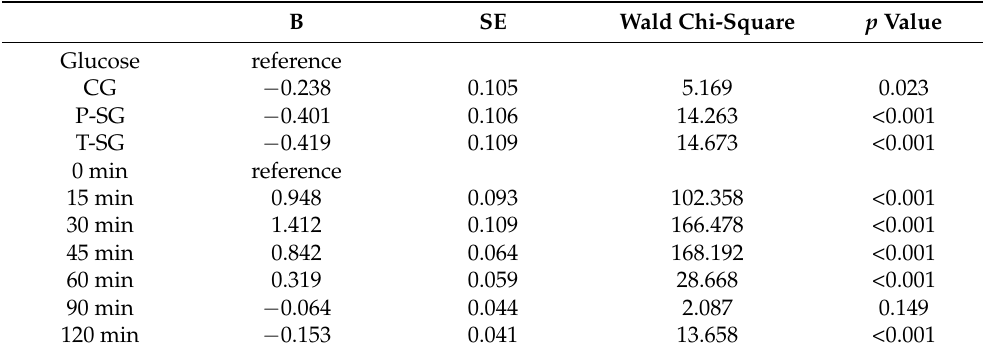
Table 1. GEE analysis results of blood glucose concentration.